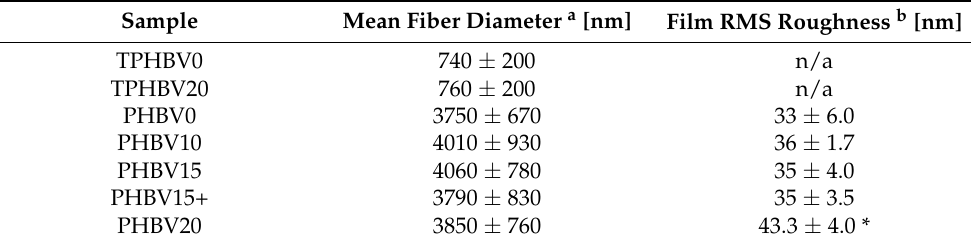
Table 3. Film surface roughness and mean fiber diameter of the electrospun mats before and after treatment with LiBH 4